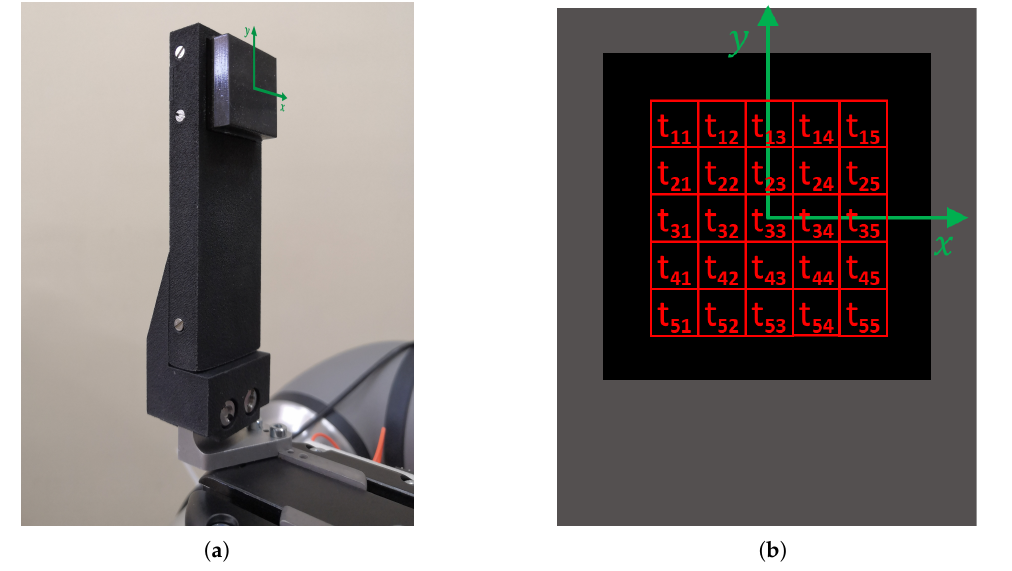
Figure 1. Sensorized finger ( a ) and taxels disposition scheme ( b